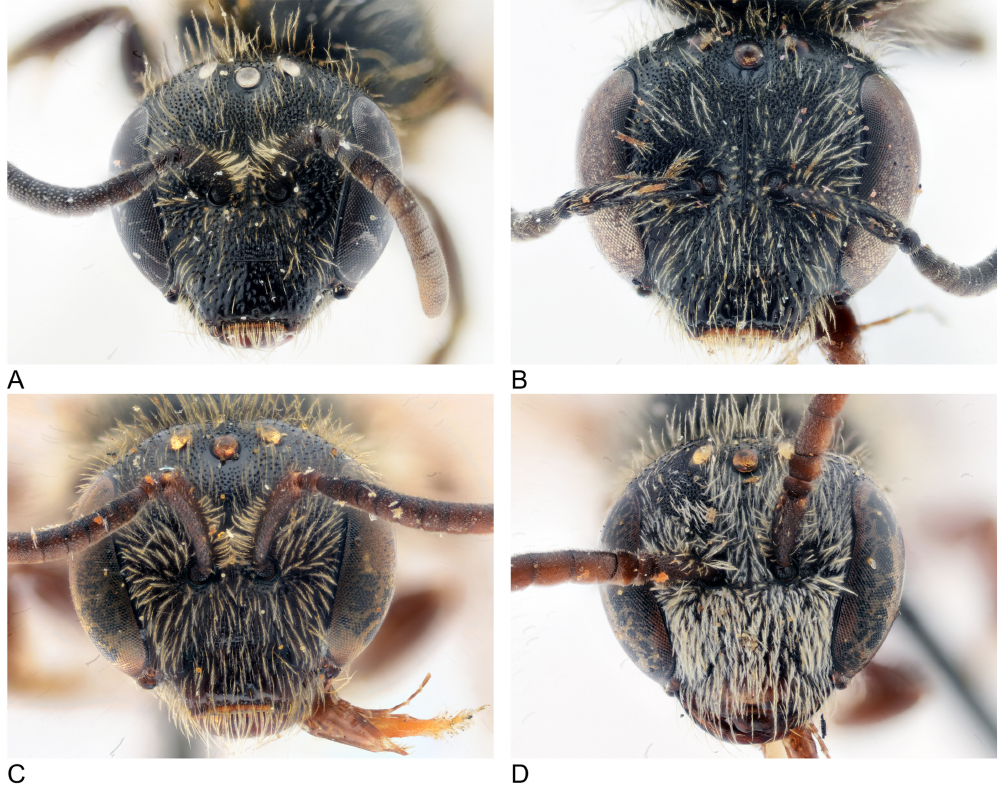
Fig. 12. Heads. A . Lasioglossum villosulum villosulum (Kirby, 1802), ♀ (France, Allier). B . L. medinai , ♀ (France, Vaucluse). C . L. villosulum trichopse (Strand, 1914), ♀ (Taiwan). D . Idem,